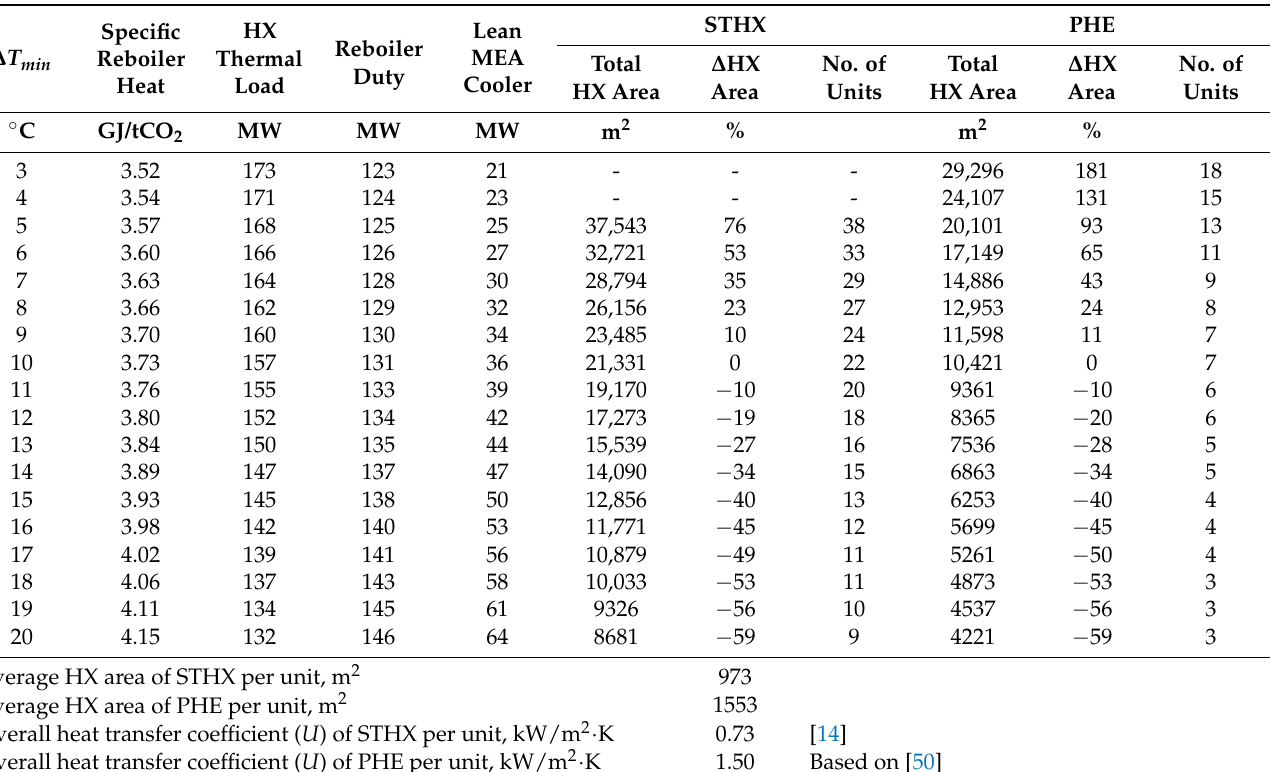
Table 10. The influence of the lean/rich heat exchanger ∆ T min on the thermal load and area of the